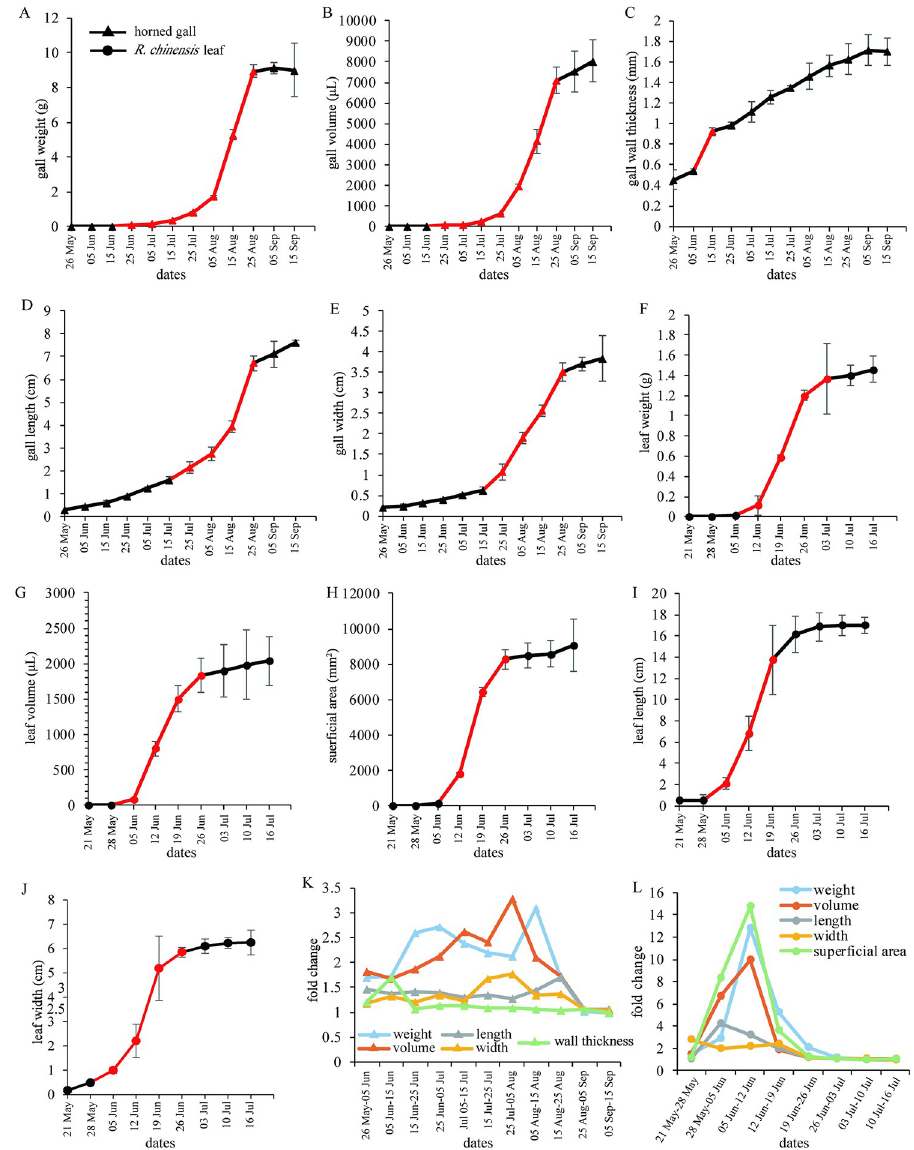
Fig 3. Developmental parameters of horned galls and R . chinensis leaflets. (A-E) Weight, volume, thickness, length, and width of horned galls during whole developmental stage, respectively. (F-J) Weight, volume, superficial area, length, and width of R . chinensis leaflets during whole developmental stage, respectively. (K-L) Fold change of developmental parameters of horned galls and R . chinensis leaflets. Growth curves indicate that development could be divided into initial, rapid growth, and slow growth stages. X axis indicates data of sample collection; red lines indicate rapid growth periods.